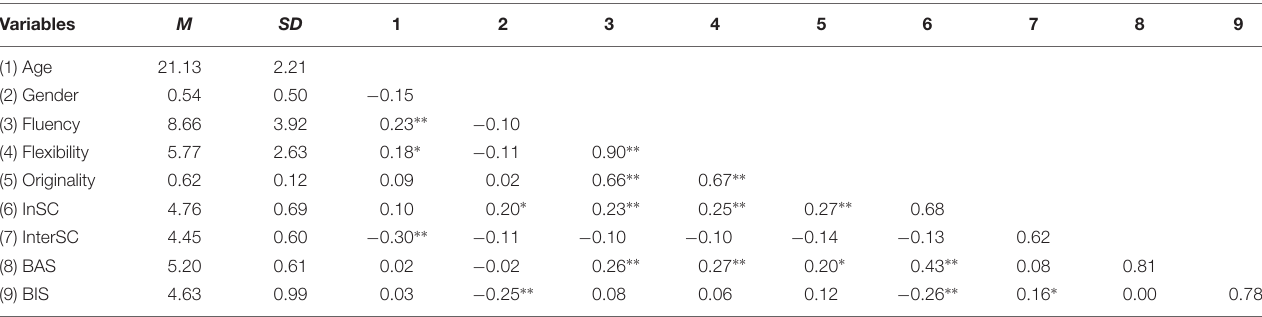
TABLE 3 | Study 2 descriptive statistics and correlations.